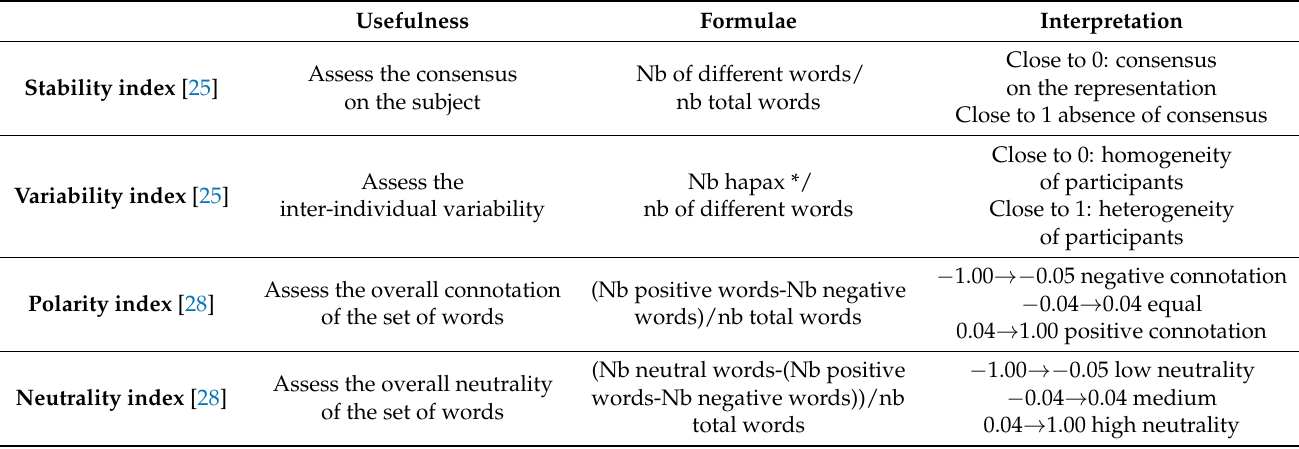
Table 1. Definitions for the lexical